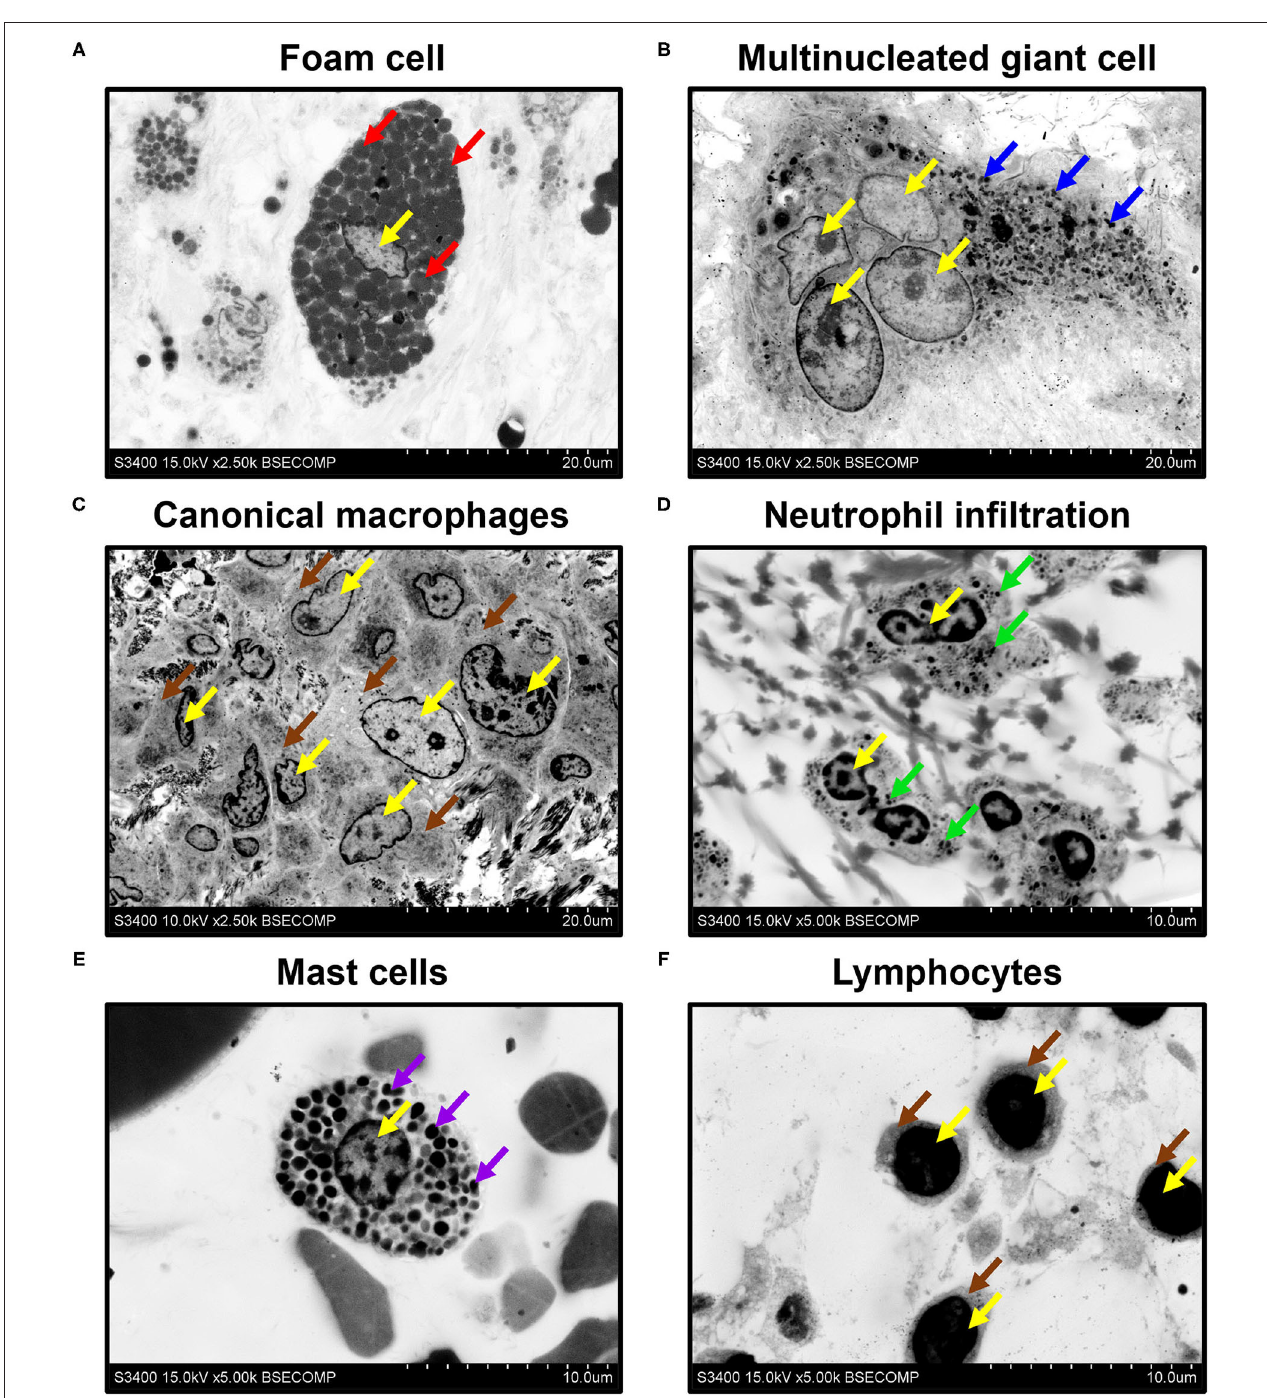
FIGURE 8 | Phenotyping of immune cells and mast cells by EM-BSEM. Nuclei are indicated by yellow arrows. Note (A) the large spherical lipid granules within the foam cells of carotid plaque (indicated by red arrows) and (B) multiple small granules within the multinucleated (foreign body) giant cells of the bioprosthetic aortic valve (indicated by blue arrows). (C) Canonical macrophages of the same valve lack granules within the cytoplasm (indicated by brown arrows). (D) The neutrophils of rapid-failing bioprosthetic aortic valve were characterised by numerous small granules within the cytosol (indicated by green arrows) and polymorphic nuclei. (E) In contrast, mast cells from the perivascular (human coronary artery) adipose tissue have large spherical inclusions in the cytosol (indicated by violet arrows) and round nuclei. (F) Lymphocytes from the same adipose tissue sample were distinct from other cells because of a high nuclear-cytoplasmic ratio (cytoplasm is indicated by brown arrows): × 2,500 magnification (scale bar: 20 µ m) for images of foam cells, multinucleated giant cells, and canonical macrophages; × 5,000 magnification (scale bar: 10 µ m) for images of neutrophils, mast cells, and lymphocytes. The accelerating voltage was 15 kV for all images, except that of canonical macrophages (10 kV).